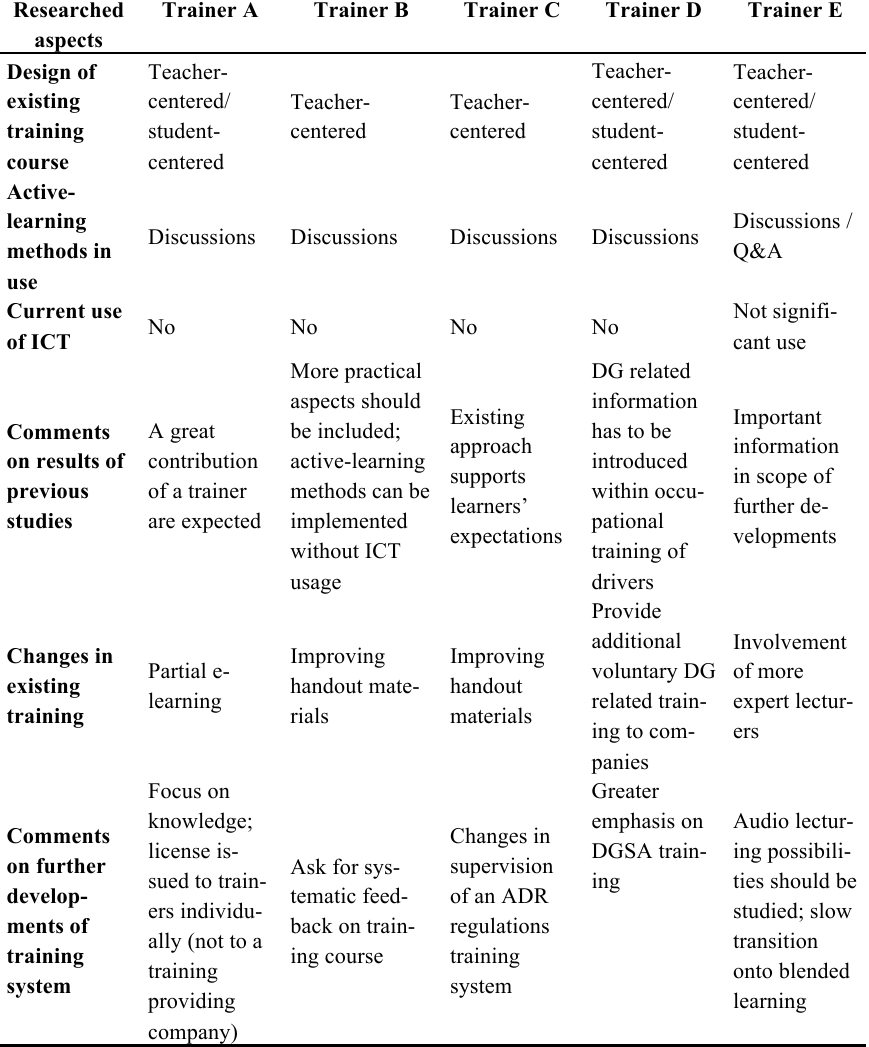
Table 3. Main findings of in-depth